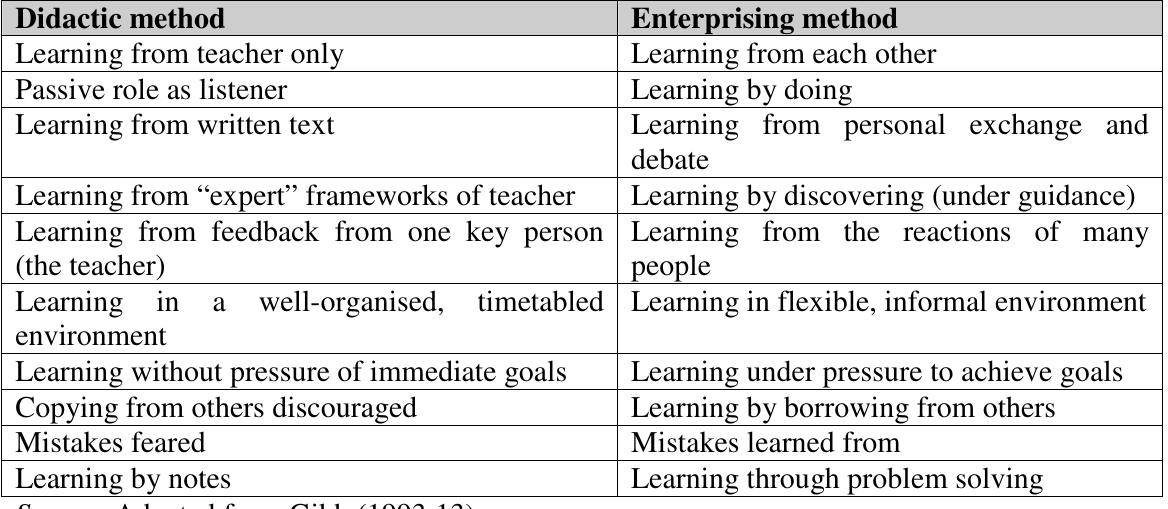
Table 1: Differentiation between “didactic” and “entrepreneurial” education approaches Didactic method Enterprising method Learning from teacher only Learning from each other Passive role as